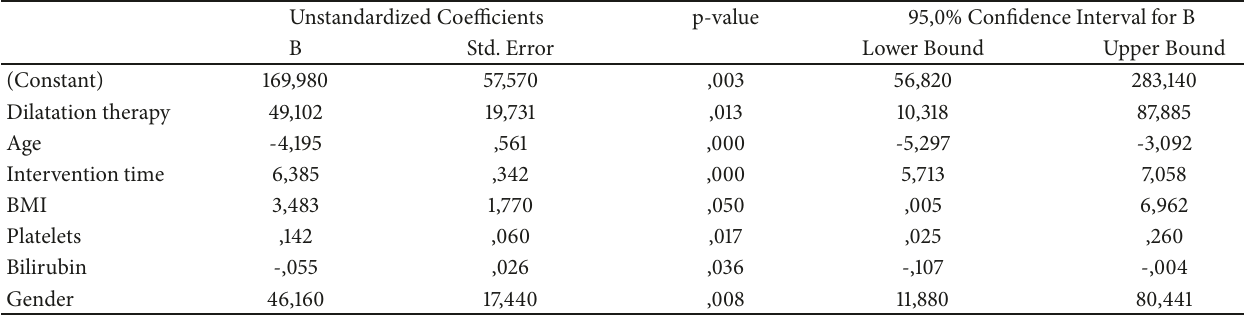
Table 3: Multivariable linear regression analysis to identify independent factors on the propofol dosage . Dilatation therapy, age, gender, interventiontime,bodymassindex,plateletcount,andbilirubinlevelwereindependentlyassociatedwiththepropofolconsumption.Propofol dose served as the dependent variable. A logarithmic transformation was applied to all metric variables which showed a skewed distribution on the original scale. In case of more than 2 values for categorical variables a dummy transformation was performed. In a first step all factors were tested in univariate models. Subsequently, significant (p < 0.05) variables were entered into a multivariable model and a backward selection based on the Wald statistic was performed. Table 3 depicts the unstandardized coefficients with standard error, p-values, and 95% confidence